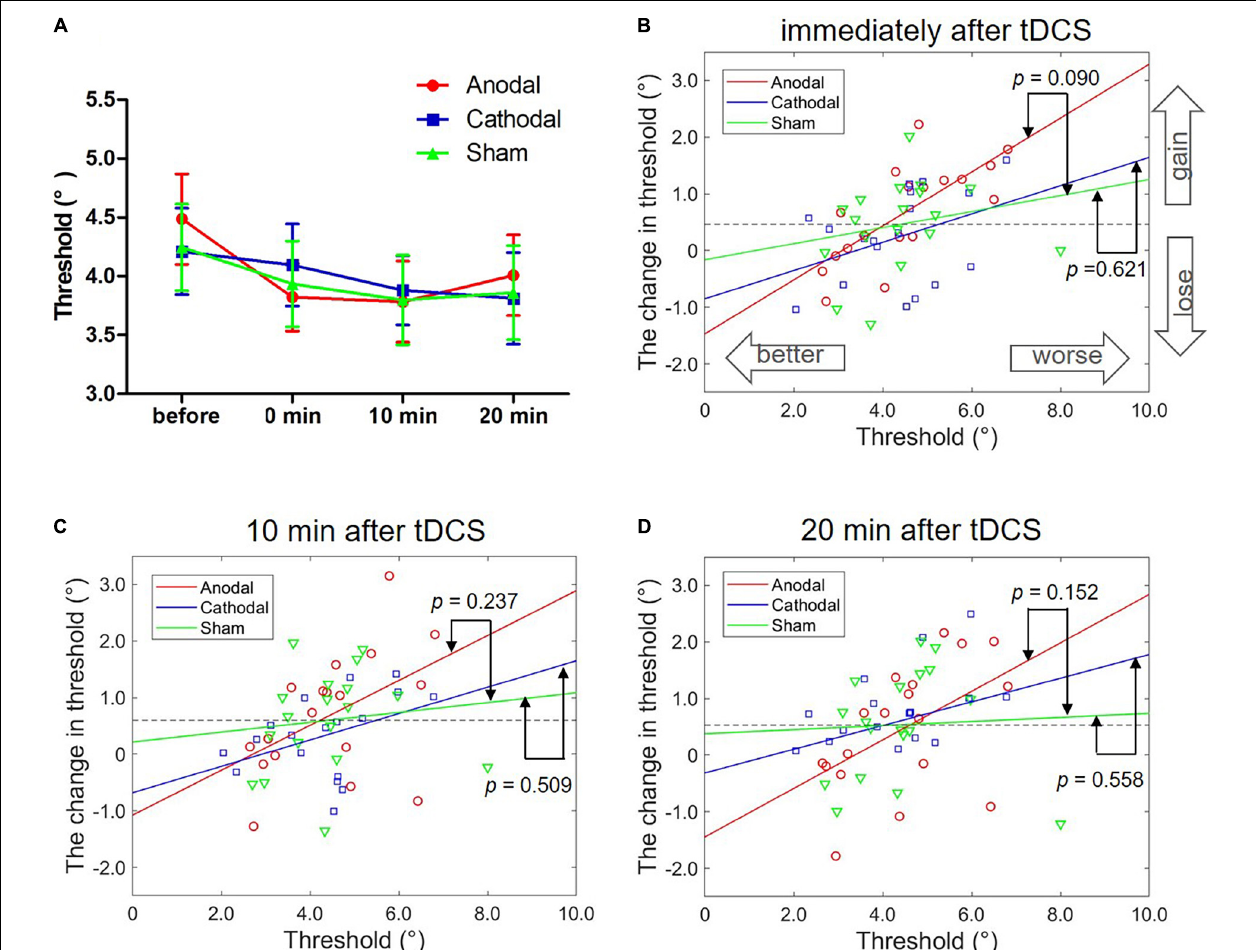
FIGURE 3 | Effects of tDCS over the left FFA on the threshold of face view discrimination. (A) The average thresholds are depicted at four times after anodal (red circles), cathodal (blue squares) and sham tDCS (green triangles). Error bars indicate standard errors (SE). (B–D) The correlation between the baseline threshold and the change amount in the threshold at different time points. p- values represent the significance level between the slopes of two linear models (anodal or cathodal vs. sham).